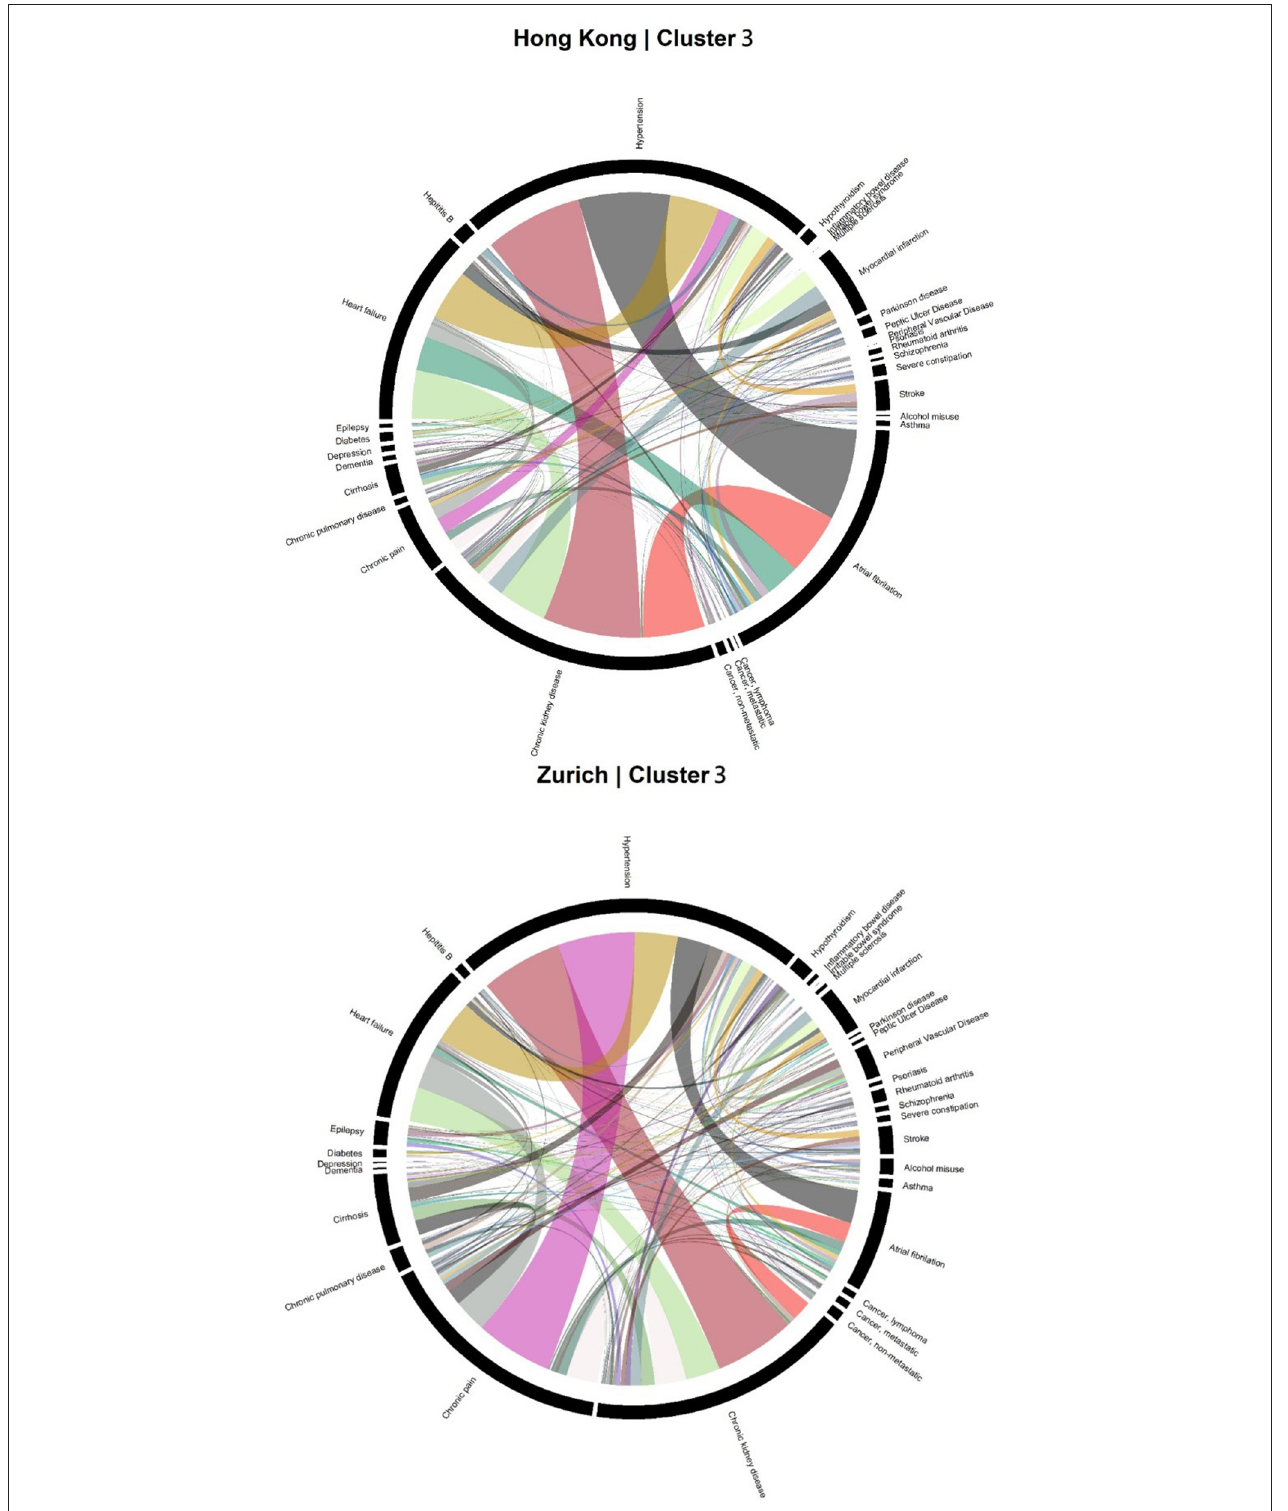
FIGURE 7 | Chord diagrams showing the frequencies of disease dyads among inpatients from Cluster H3 of Hong Kong and Cluster Z3 of Zurich (chronic kidney disease clusters).